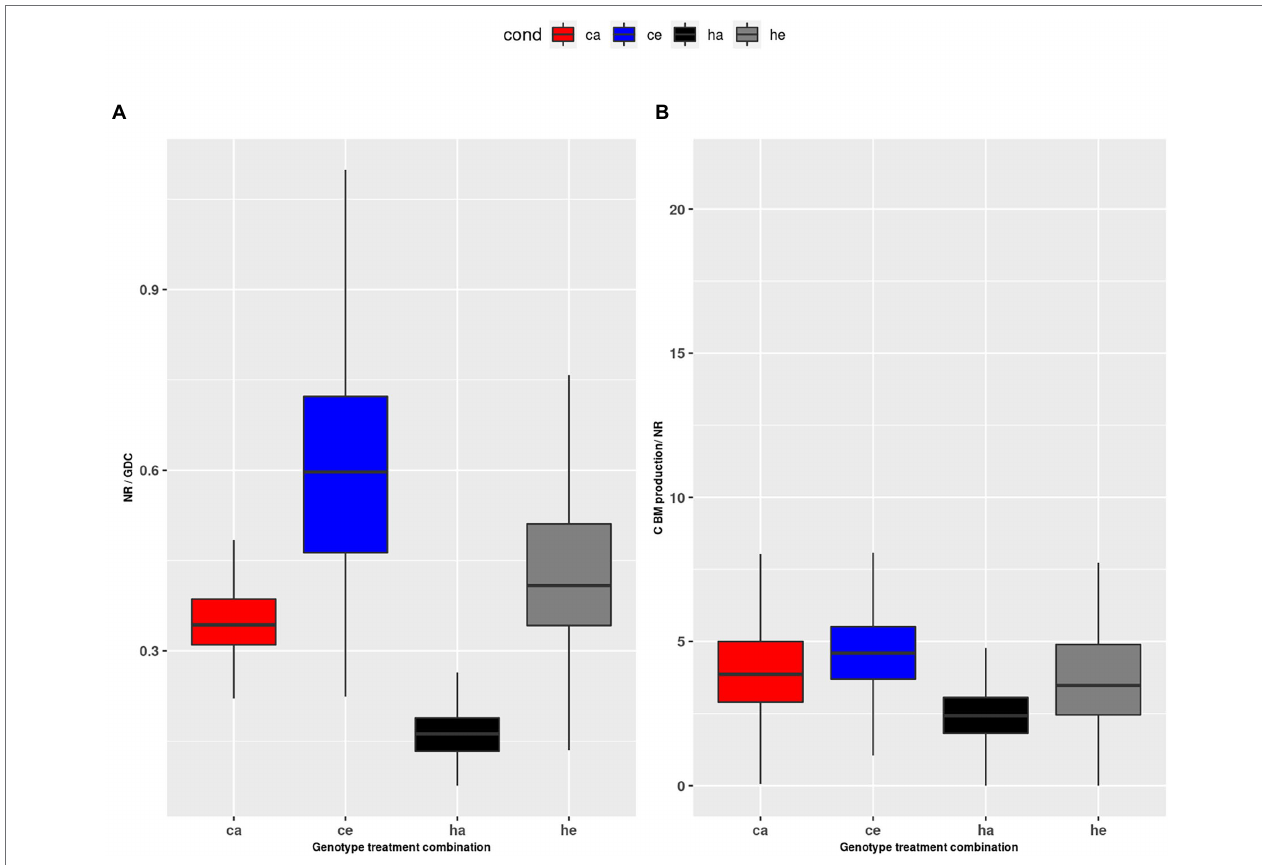
FIGURE 8 | (A) Ratio of NR to GDC during the day, (B) ratio of HP2BMEXP to NR during the day. Col-0 ambient: red, Col-0 eCO 2 : blue; hpr1-1 mutant ambient: black, hpr1-1 mutant eCO 2 : grey. Data based on 20 simulations. Boxplots are dodged by 0.25 h in order to prevent